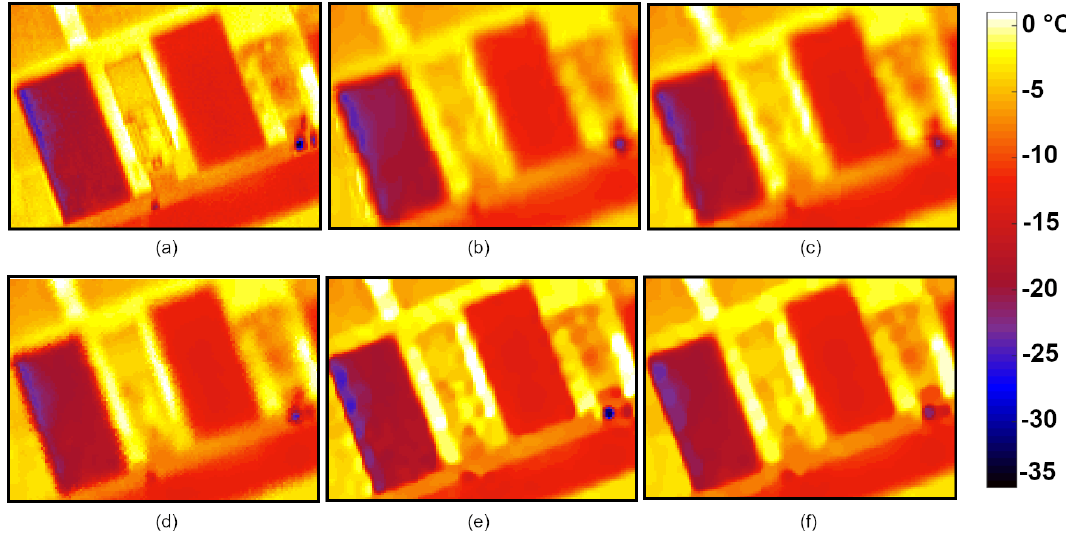
Figure 6. Comparisons among HR images obtained by different methods (detail of the I1 image). Hereafter, we recall the method and the real global Kelvin degrees range in brackets, since each image is depicted in the same color map. ( a ) Ground truth image ([ − 36.70, 5.28]). ( b ) Bicubic HR image ([ − 23.66, 1.84]). ( c ) EDSR HR image ([ − 23.89, 1.96]). ( d ) RISR HR image ([ − 25.13, 1.95]). ( e ) ASR2_s HR image ([ − 32.35, 2.77]). ( f ) ASR2_m HR image ([ − 25.51,